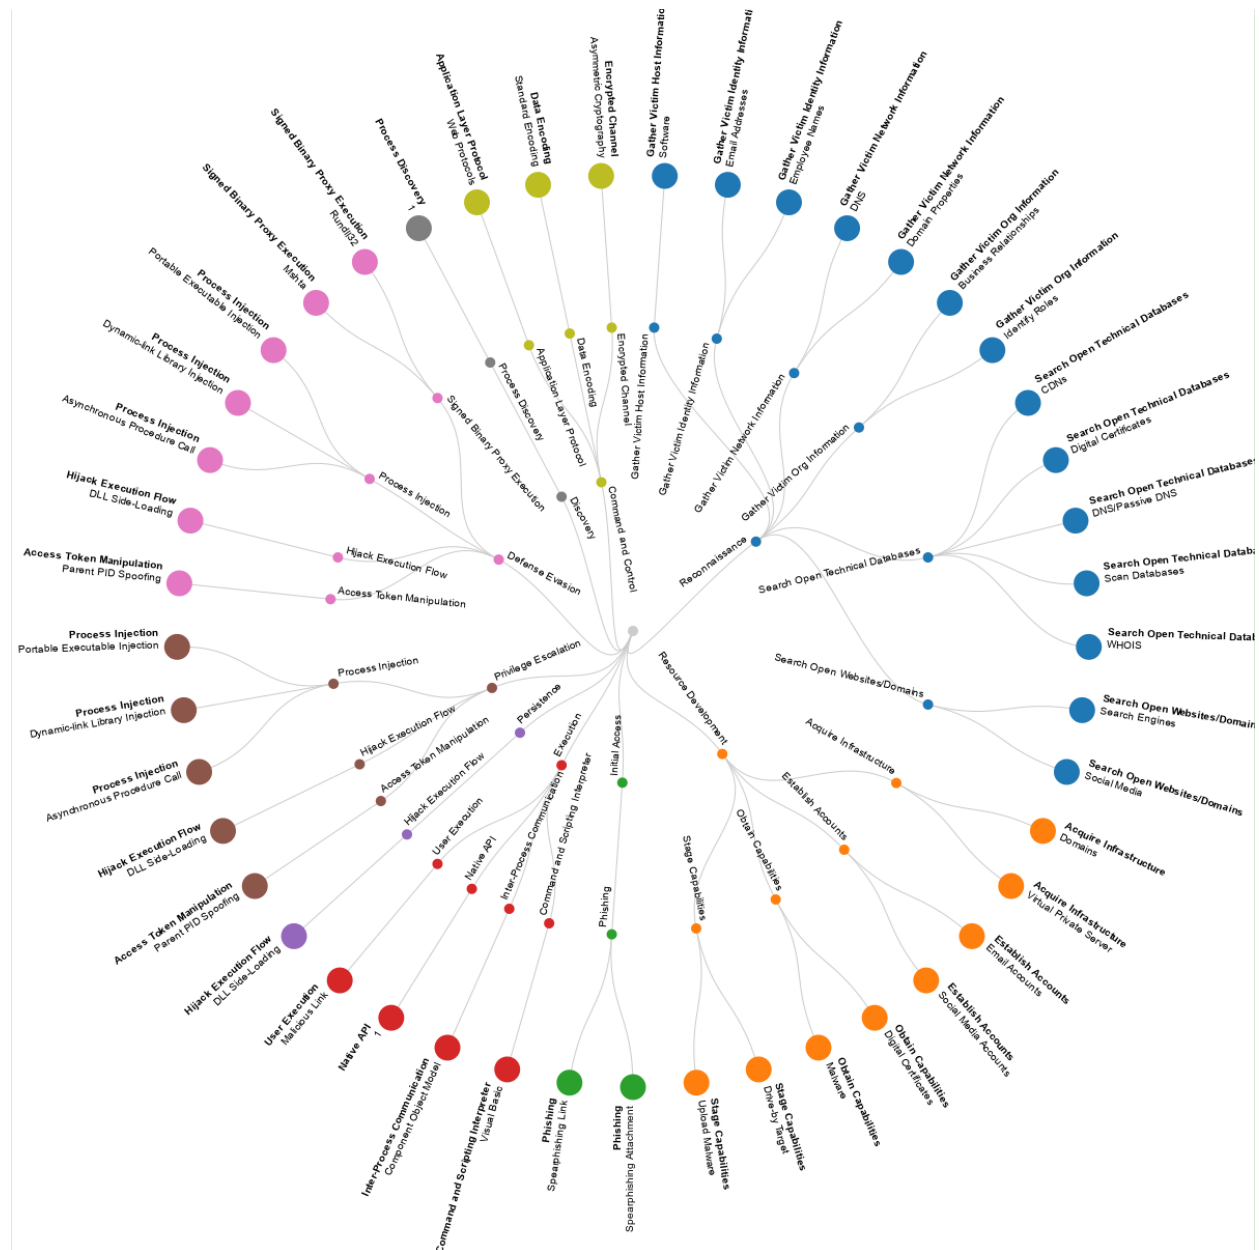
Figure 1. ATT&CK model of the emulated threat